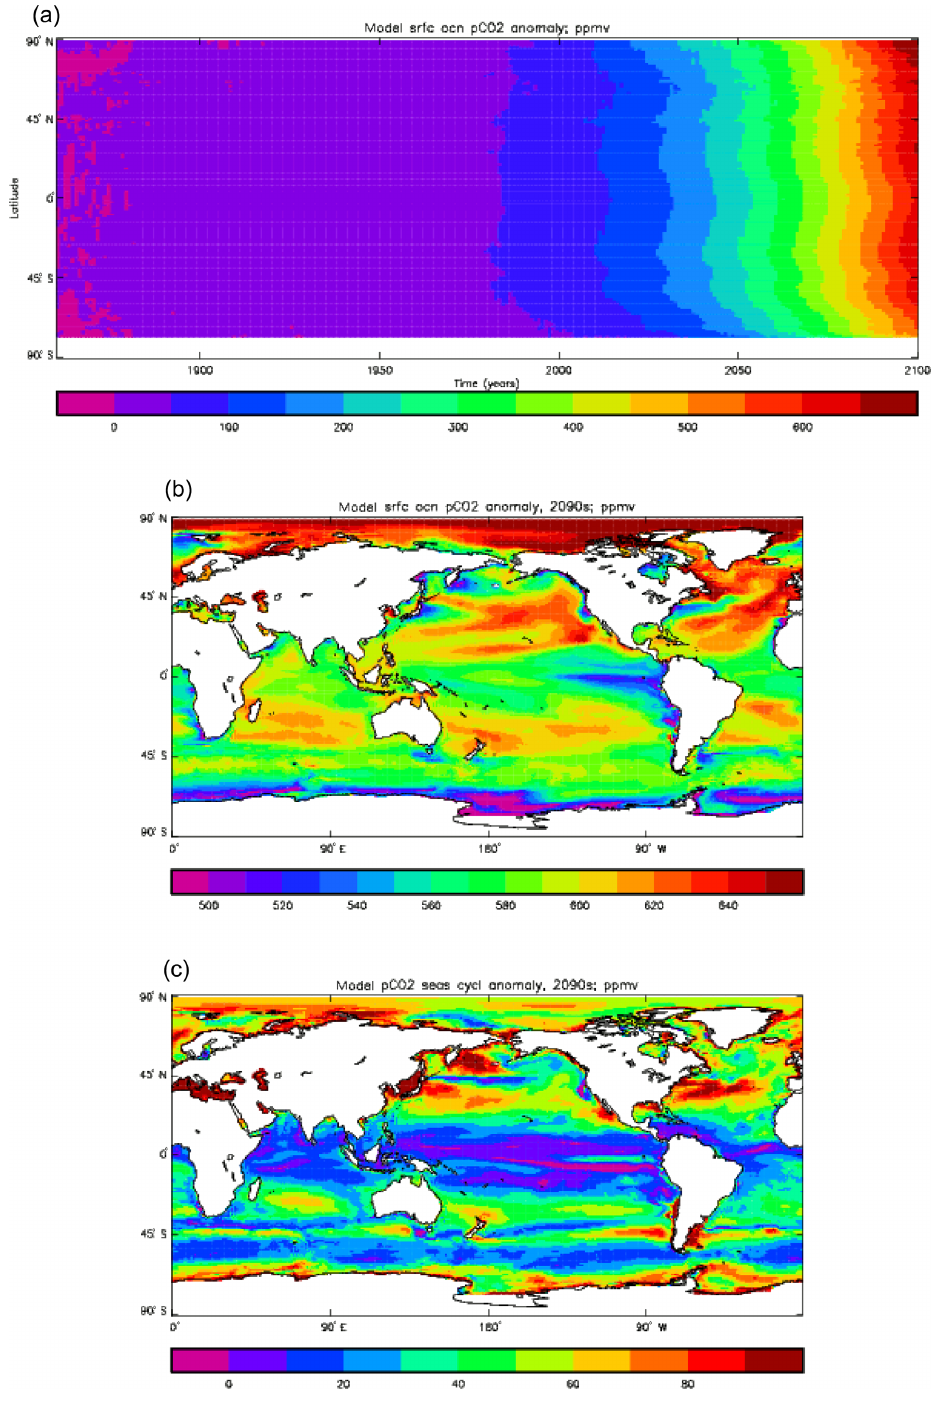
Figure 39. Change in surface p CO 2 (ppmv) during the model years 1860 to 2099 in the CMIP5 historical and RCP8.5 simulations. (a) The anomaly over the period of the simulations, calculated by subtracting the annual means of the piControl simulation from those of the historical and RCP8.5 simulations. (b) The decadal mean anomaly during the model years 2090–2099, calculated by subtracting the relevant years of the piControl from those of the RCP8.5 simulation. (c) The seasonal cycle amplitude anomaly averaged over the model years 2090–2099, calculated as for panel (b)